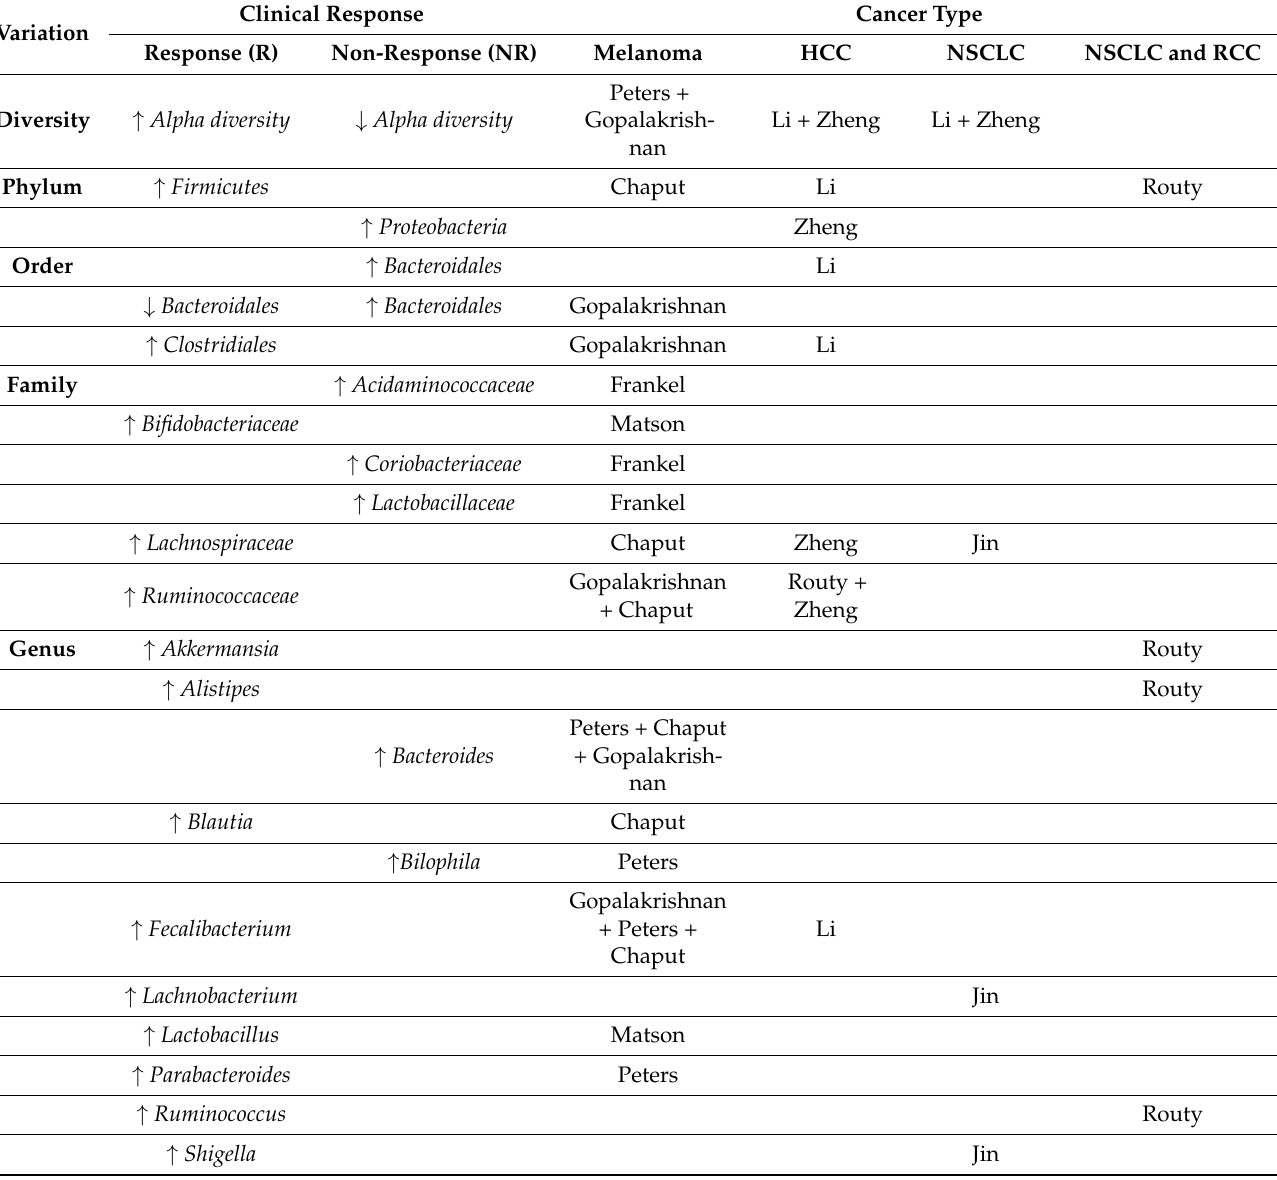
Table 2. The gut microbiome in